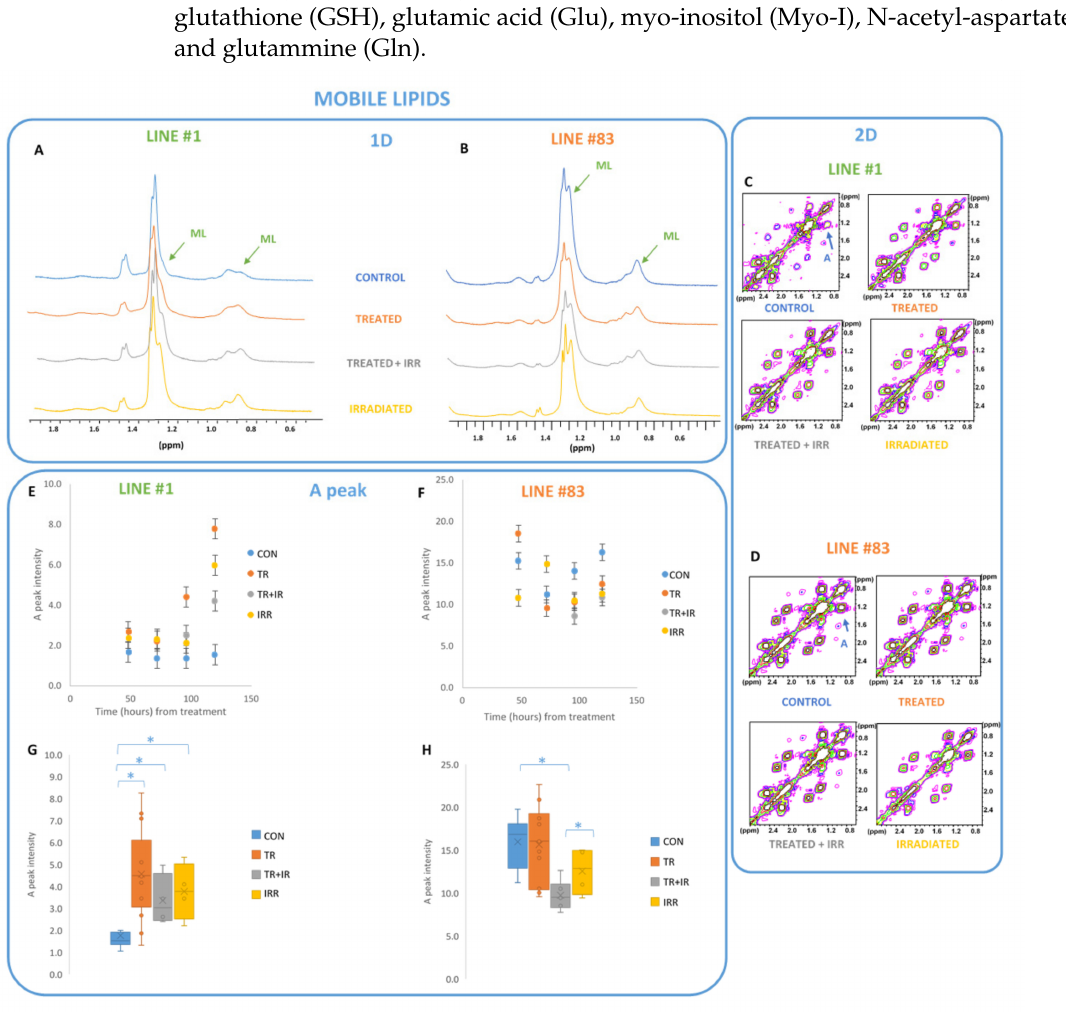
Figure 2. Mobile Lipid region of 1D ( A , B ) and 2D ( C , D ) spectra of cell line #1 ( A , C ) and line #83 ( B , D ) in the four different conditions (control—CON; ligand #190 treated—TR; photon beam irradiated—IR; and irradiated plus treated—IR+TR) 96 h after treatment. In the 2D contour plots (C and D), different colours indicate different intensity levels. The 2D COSY A peak (1.28–0.89 ppm) intensity, arising from mobile lipids CH 2n and terminal CH 3 correlation, is shown as a function of time from ligand #190 treatment for line #1 ( E ) and line #83 ( F ). Box and whiskers plot comparing the A peak intensity values in the four different conditions for line #1 ( G ) and line #83 ( H ). Asterisks indicate statistically significant variation (Student’s t -test, p value <